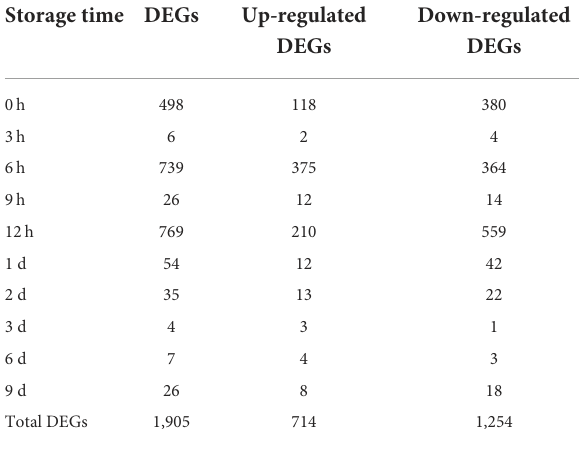
TABLE 1 Numbers of DEGs at different storage time after ultrasound treatment. Storage time